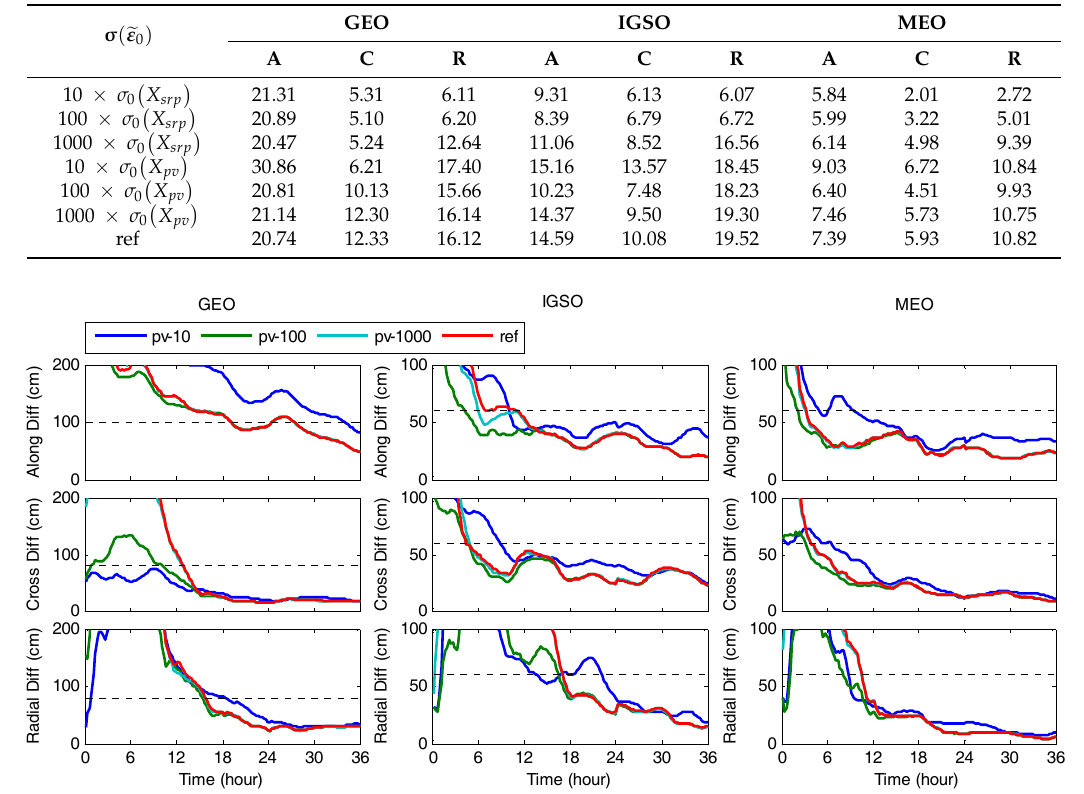
Figure 7. Time series of the average orbit accuracy using different a priori STD of PV parameters. The BRDC product is used as the initial orbit. The horizontal black dotted line represents the convergence criteria for each direction.